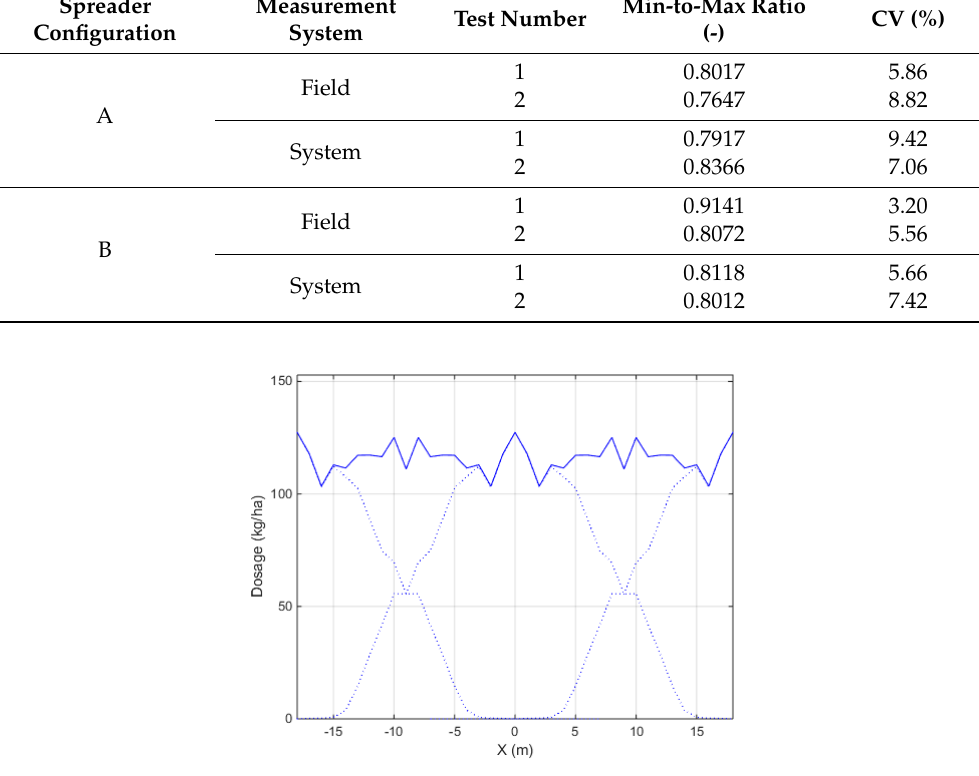
Figure 12. Total transverse spread pattern (solid line) with overlap between spread patterns of subsequent swaths (dashed line). The spread pattern was measured by the camera system at configuration B (18 m working width, first replicate). A CV value of 5.66% was found.